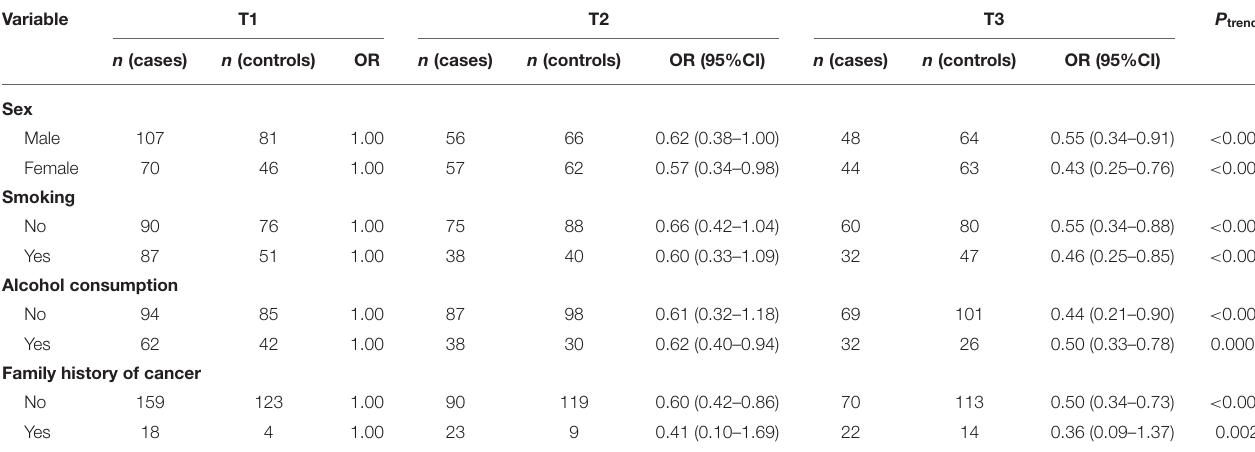
TABLE 4 | Stratification analysis of dietary fiber intake and oral cancer.